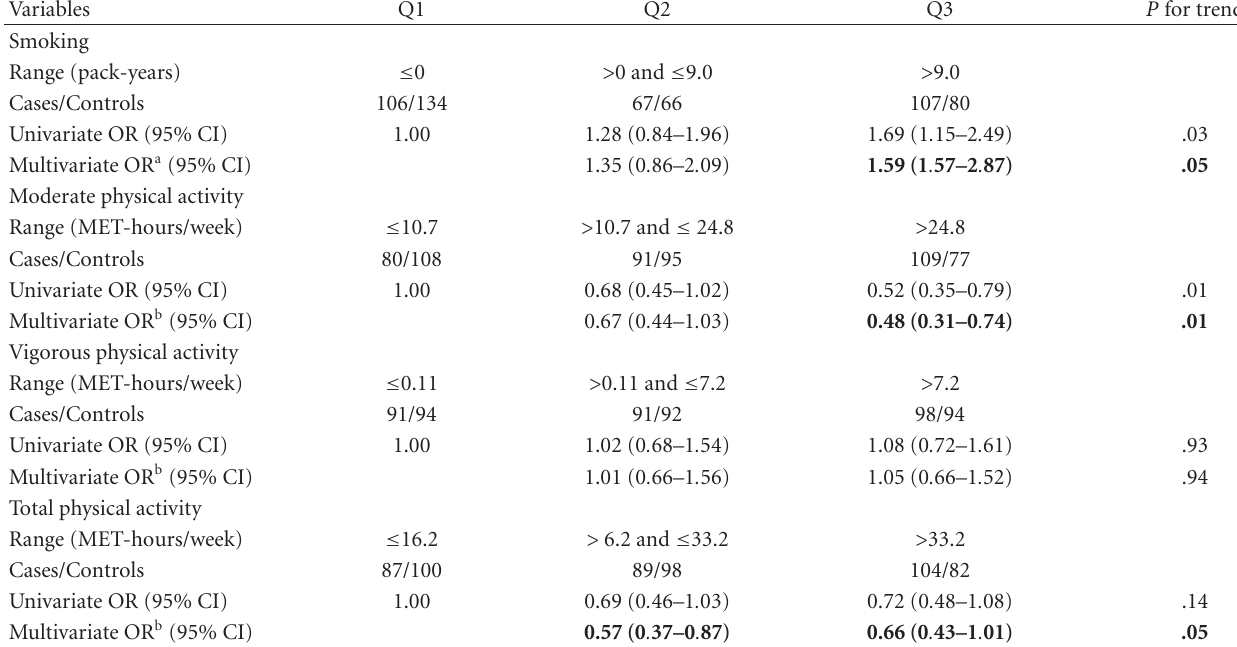
Table 3: Odd ratios and 95% confidence intervals for breast cancer risk associated with lifestyle factors, including smoking and physical